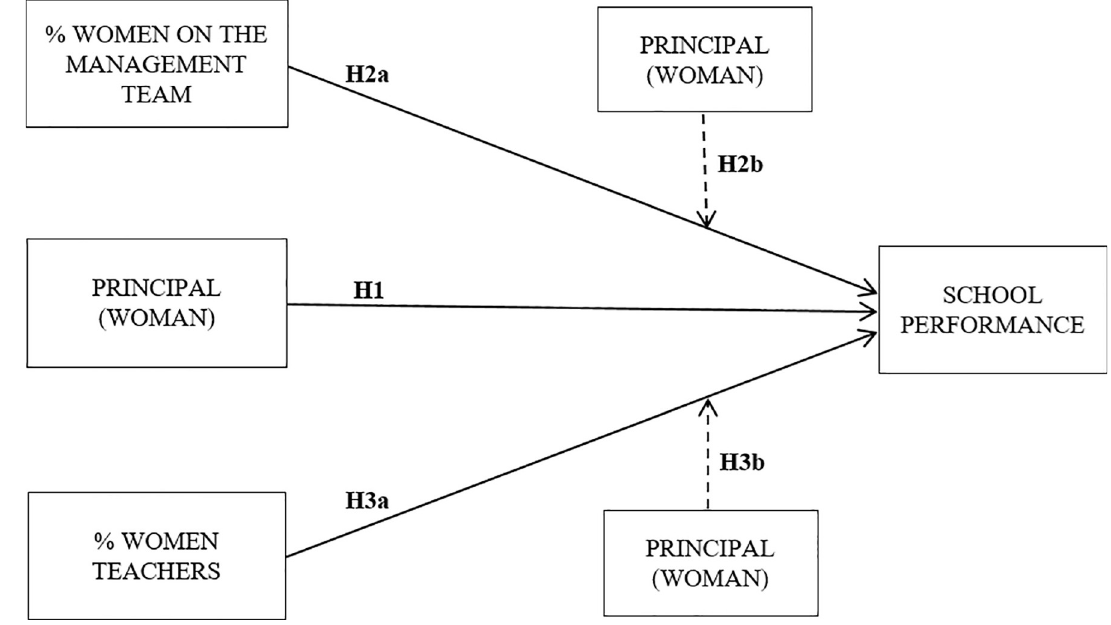
Fig 1. Relationships between the female presence in different hierarchical positions and